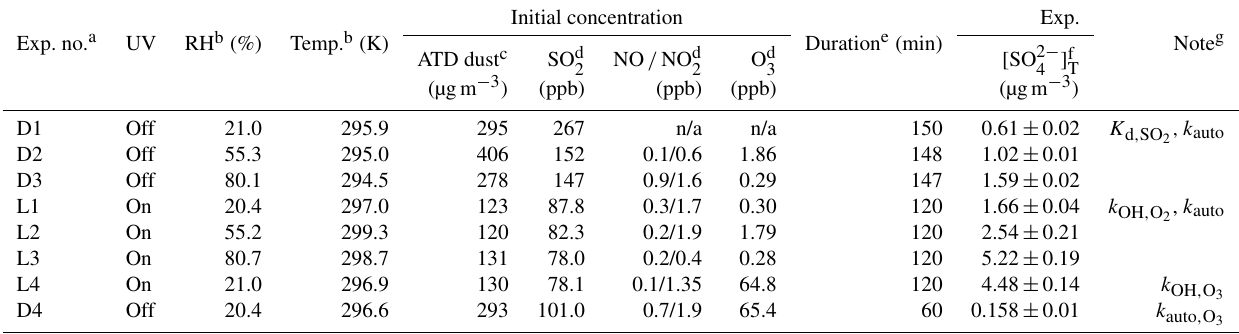
a “D” denotes experiments under dark conditions. “L” denotes experiments with UV light. The dataset D1–D3 and L1–L4 were obtained from the recent laboratory data reported by Park and Jang (2016). Dataset D4 was newly added here to estimate the kinetic parameter of heterogeneous autoxidation of SO 2 in the presence of ozone. b The accuracy of RH is ± 5%. The accuracy of temperature is ± 0.5K. c The mass concentration of ATD particles were calculated combining SMPS data, OPC data, the density of dust particles (2.65gcm − 3 ) , and the